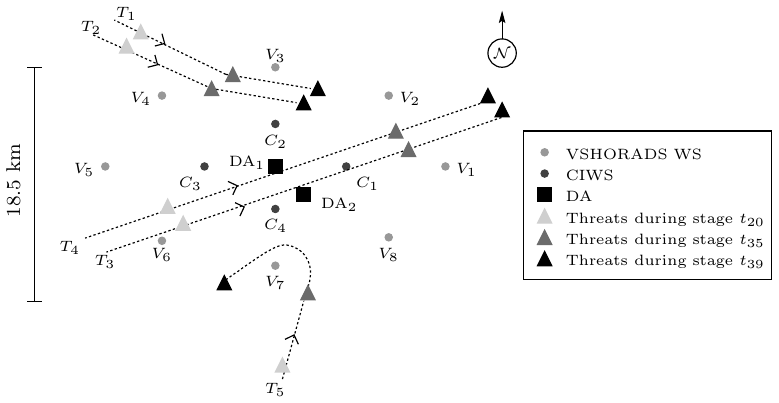
Figure 3: Top view of the locations of threats T scenario in Figure 2 during stages t